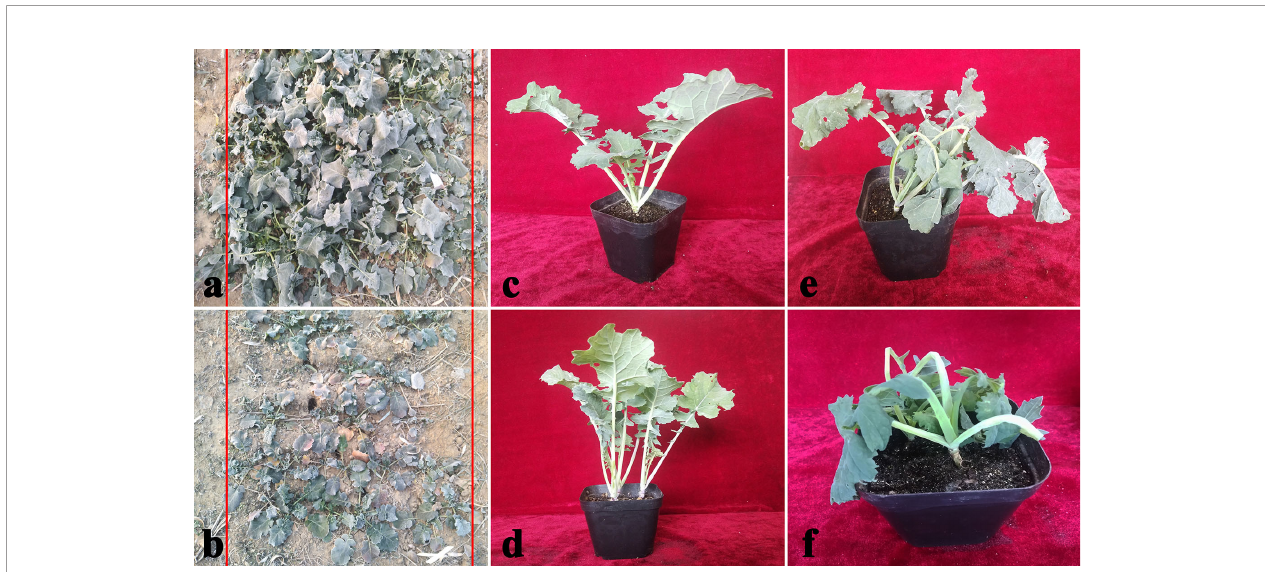
FIGURE 2 | Phenotypic symptoms of cultivars 16NTS309 (A, C, E) and Tianyou2238 (B, D, F) in response to cold stress. Morphological characteristics of B. napus in December in the natural environment (A, B) , representative phenotypes of the plants under non-cold (C, D) , and cold stress conditions (E, F) .